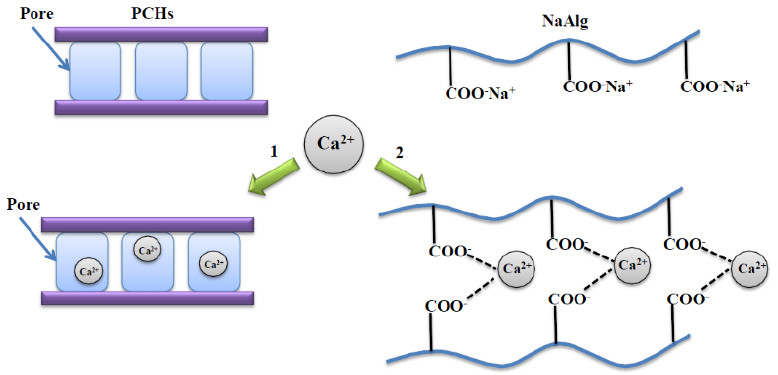
Figure 7. Possible interaction of NaAlg and PCHs with divalent cation (Ca 2+ ) in ionotropic gelation process.